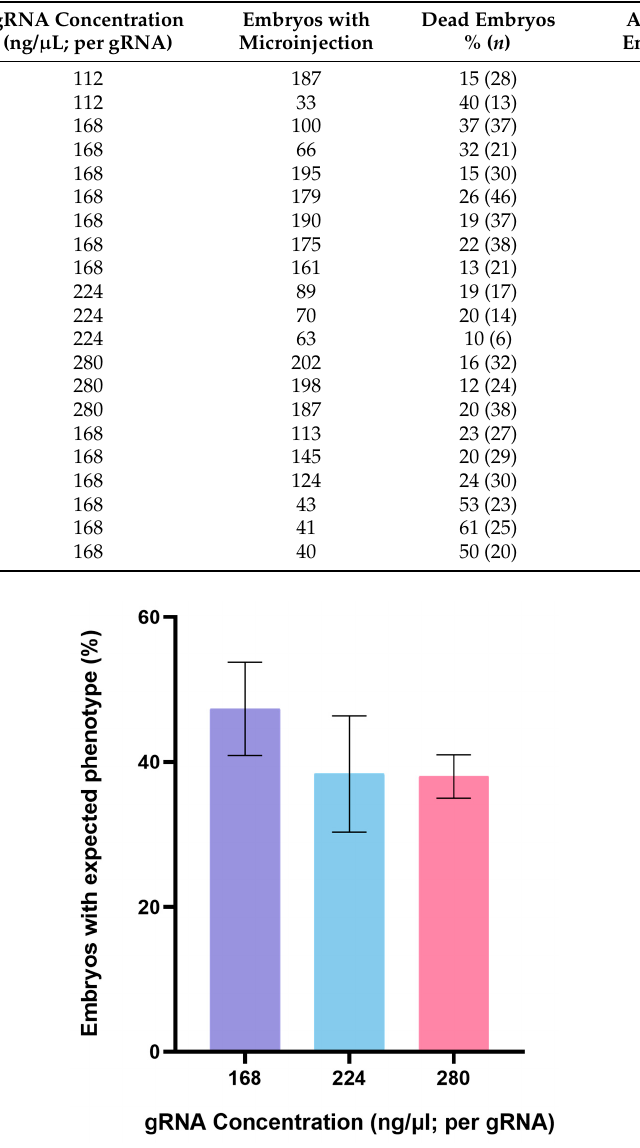
Figure 3. Ratios of mutated embryos in different gRNA concentration of two gRNA combinations ( p > 0.05). The data of ratios were presented as the mean ± standard deviation ( n = 3), and they were statistically analyzed by one-way ANOVA with a Tukey test.